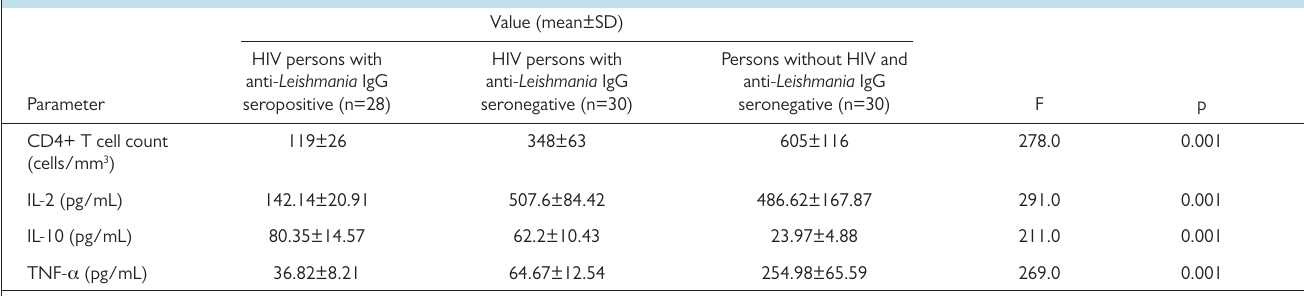
Table 3. Comparison of cytokines and CD4+ T cell count and differentials of participants with and without anti-Leishmania